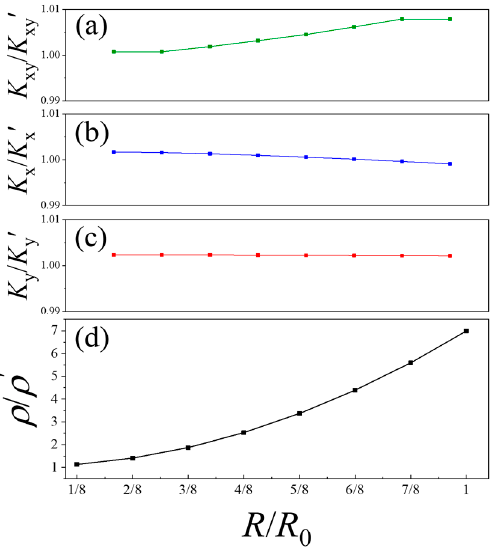
pentamode material.